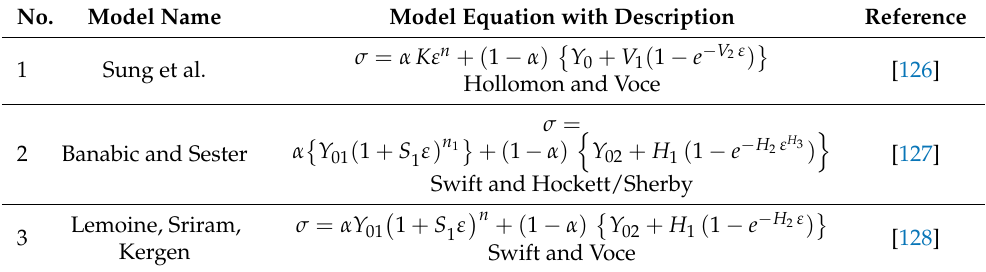
Table 6. Combined models of flow